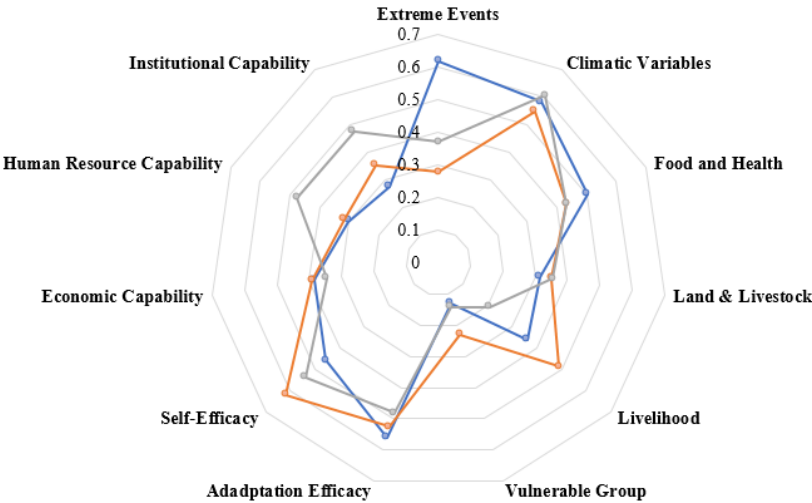
Figure 7. Spider diagram of vulnerability based on major components of LVI of the study area.